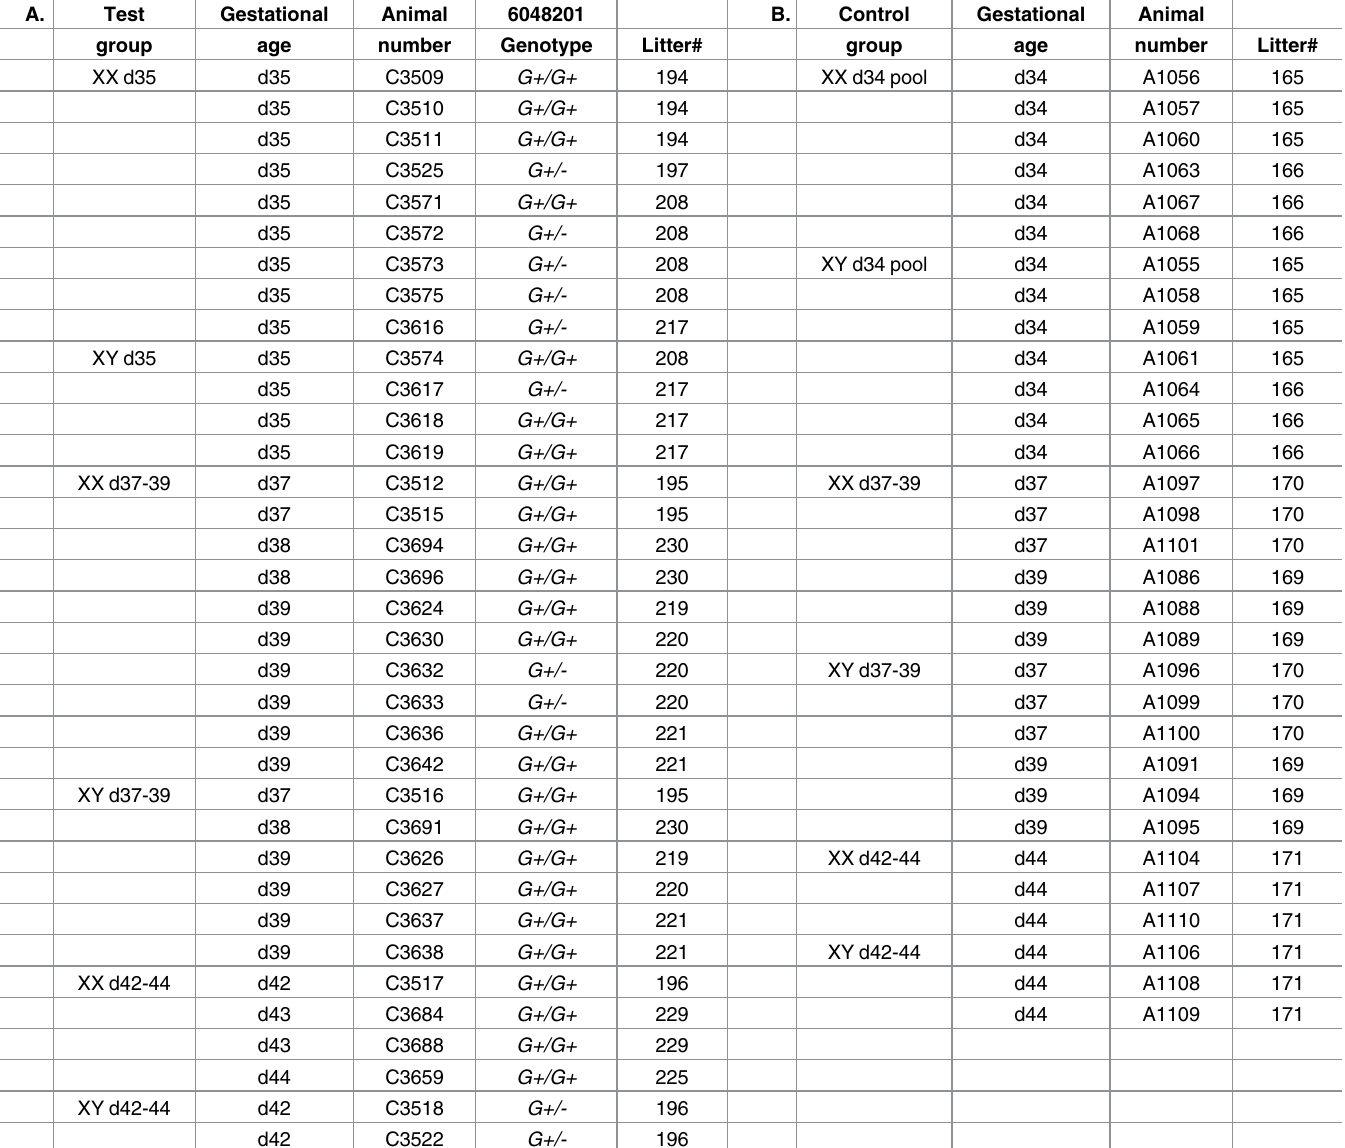
Table 4. Embryonic gonad pairs for RNA-seqwere collected at d34-44 from embryos at risk of XX DSD, XY littermate controls, and XX and XY age- matched controls.